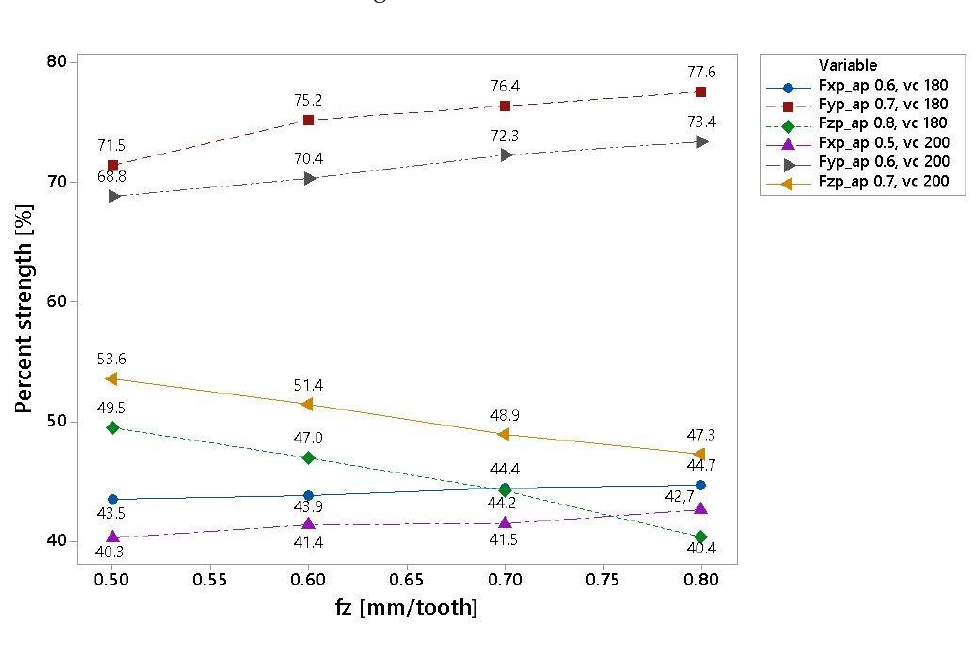
Figure 5. Graphical representation of Fz with varying cutting conditions.